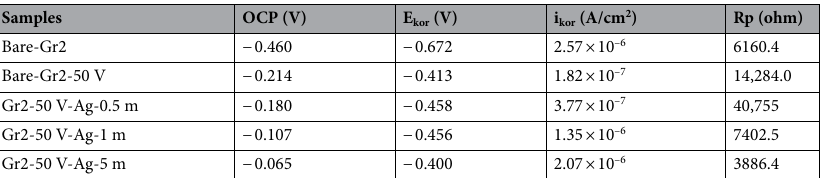
Table 3. Corrosion parameters obtained from polarization curves taken at 1 mV/s scanning speed of bare Gr2, bare nanotube and AgNPs-deposited nanotubes at 36.5 °C in 1.0X SBF.